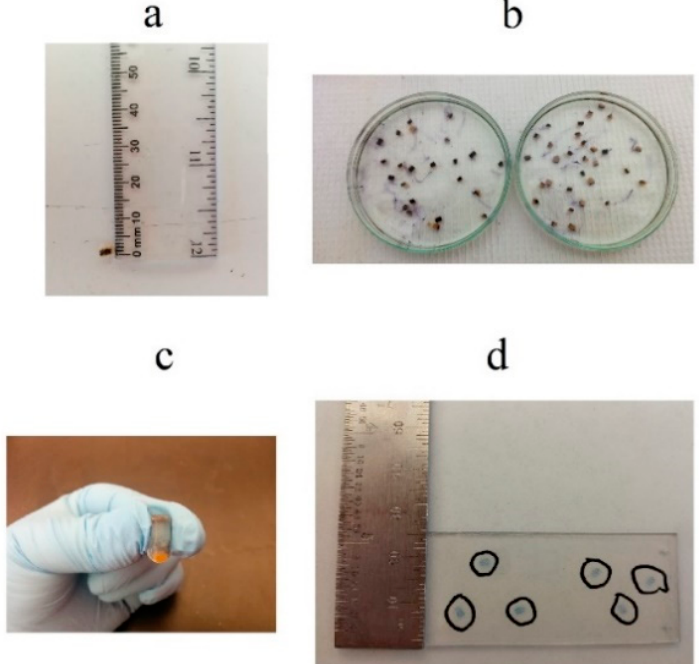
Figure 3. Specimen cutting scheme in each laboratory panel.